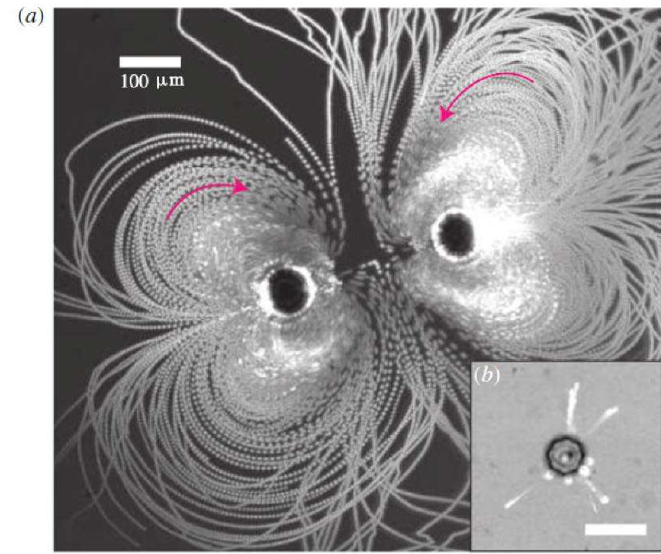
Figure 3. Microstreaming generated by ( a ) a bubble pair and ( b ) a single bubble driven at an acoustic frequency of 104 and 148 kHz, respectively. Reproduced with permission from [34].